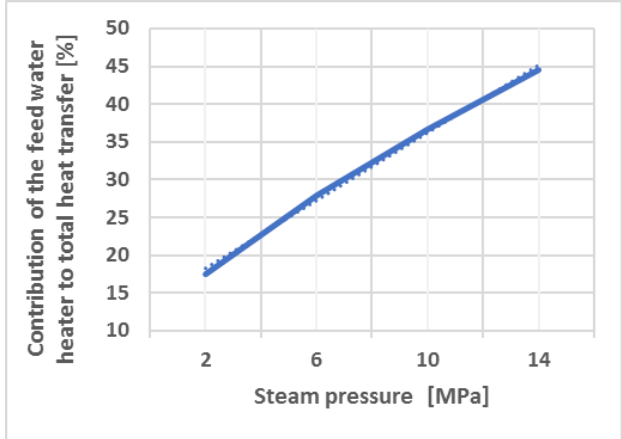
Figure 3. Percentage share of total heat taken over by the feed water heater depending on the operating pressure at the constant temperature of feed water and steam temperature [own study].